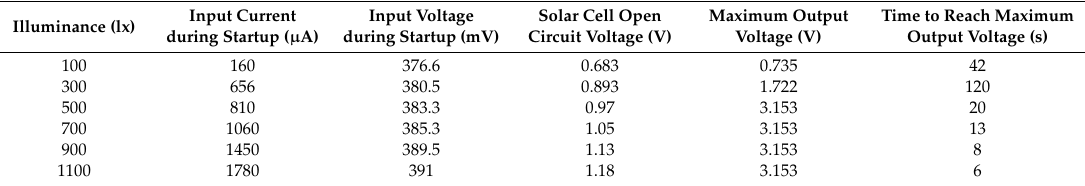
Table 2. Relevant parameters measured for the three photovoltaic cells in parallel with boost regulator setup.